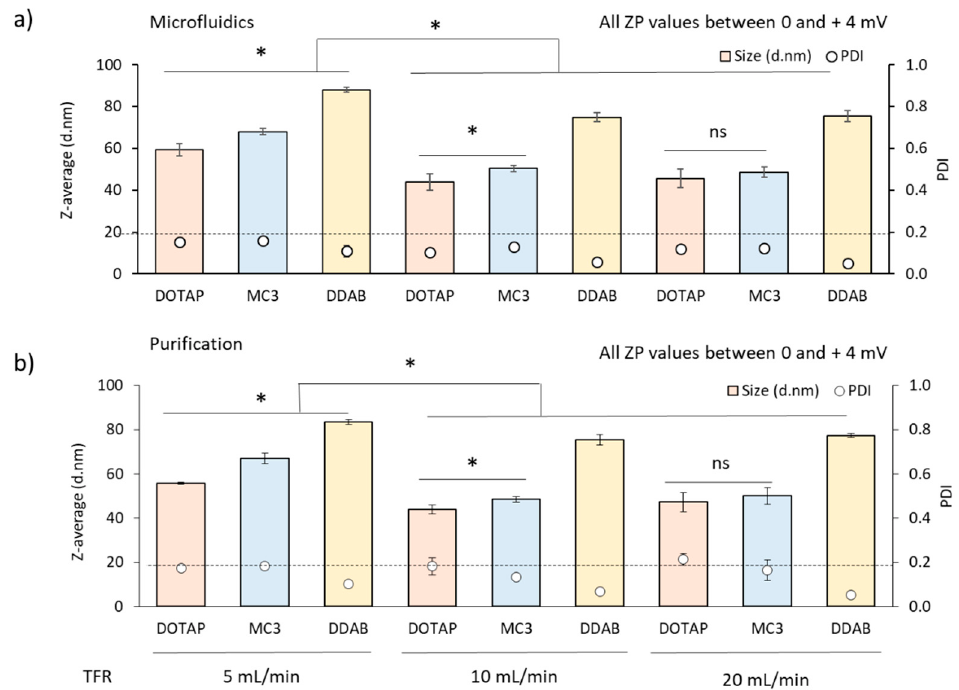
Figure 2. Effect of the total flow rate (TFR) on the physicochemical attributes of DOTAP (pink), MC3 (blue) and DDAB-based (yellow) lipid nanoparticles produced by microfluidics at 3:1 FRR using citrate buffer pH 6 100 mM as an aqueous buffer. cLNPs were purified via dialysis using TRIS buffer pH 7.4 10 mM whereas iLNPs were dialysed against PBS pH 7.3 10 mM. Particle size (bars) and PDI (open circles) of the LNPs produced using microfluidics before ( a ) and after ( b ) purification via dialysis. Results represent the mean of at least 3 independent batches and the standard deviation is plotted as error bars. ZP (zeta potential). Significant differences are shown as * p < 0.05and ‘ns’, when no statistical significance observed.